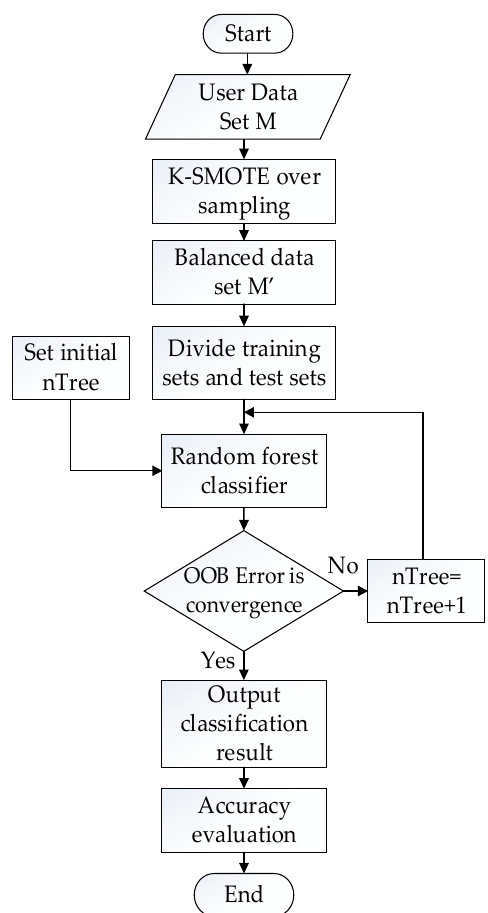
Figure 4. The proposed process of electricity theft detection.